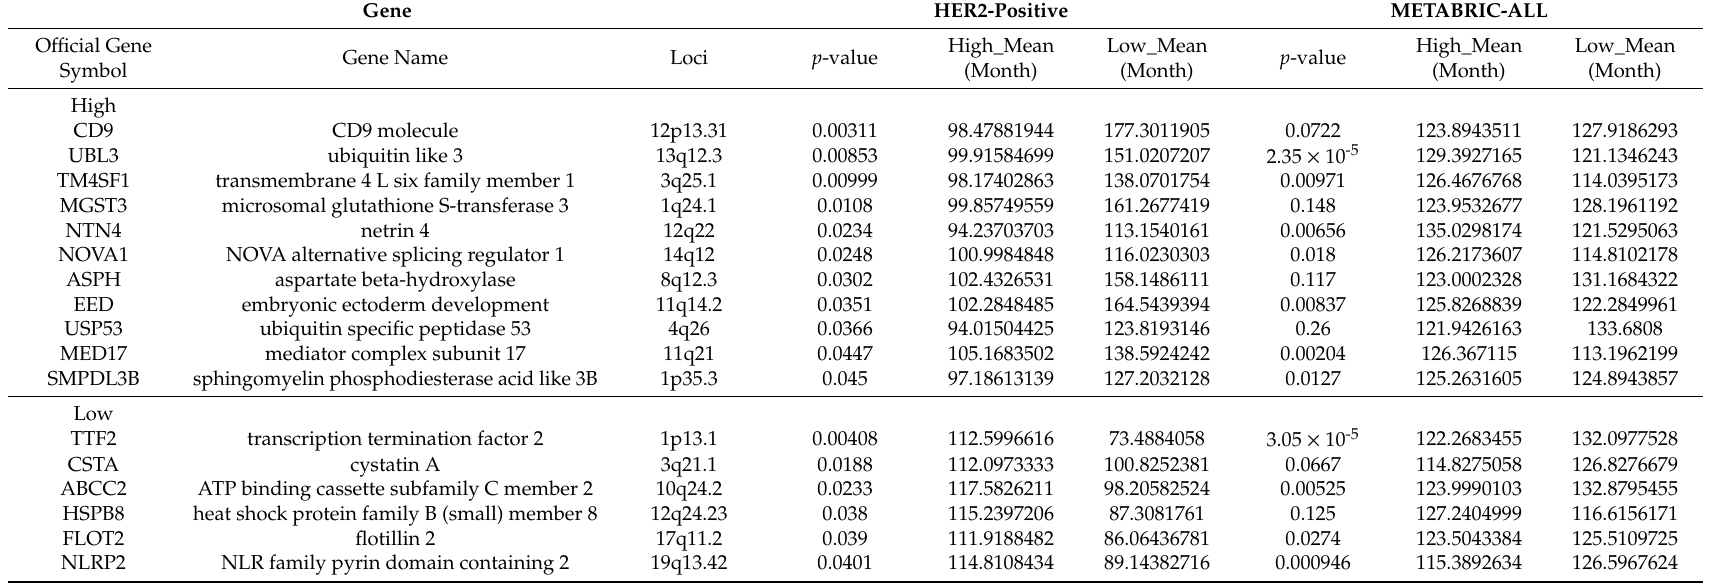
Table 3. Signature Genes Associated with Poor Survival of HER2-positive Breast Cancer Patients.